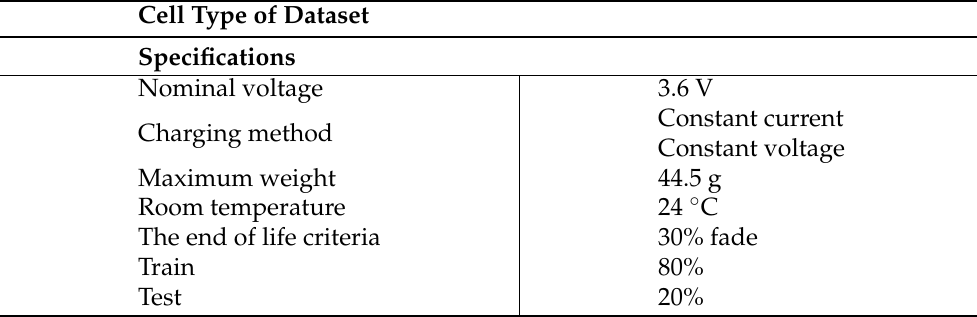
Table 2. Cells information.